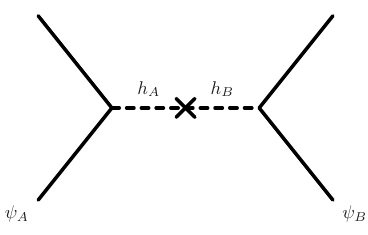
Figure 1 . Higgs portal interaction that keeps the A and B sectors in